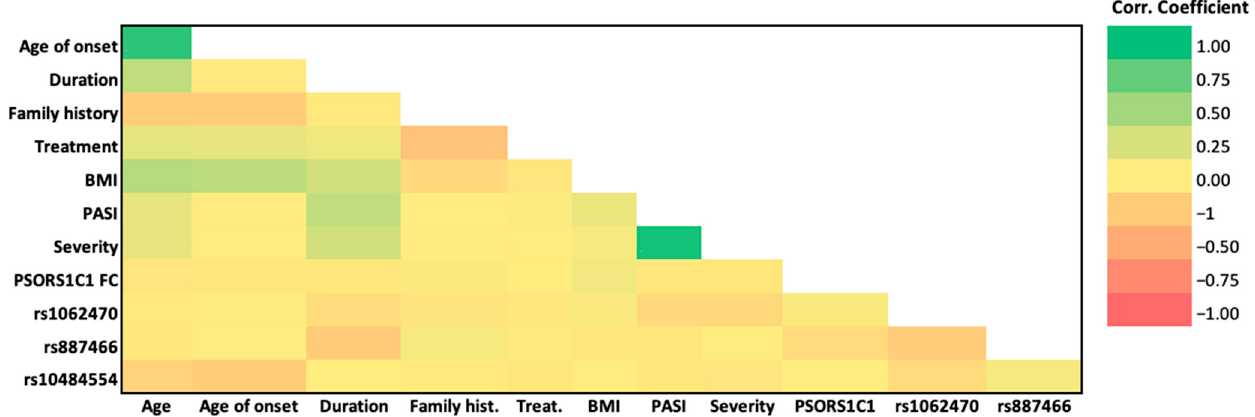
Figure 5. Heatmap presents the inter-relationship among the studied SNPs, PSORS1C1 gene expression, and clinicopathological features. (BMI, Body Mass Index; PASI, Psoriasis Area Index).